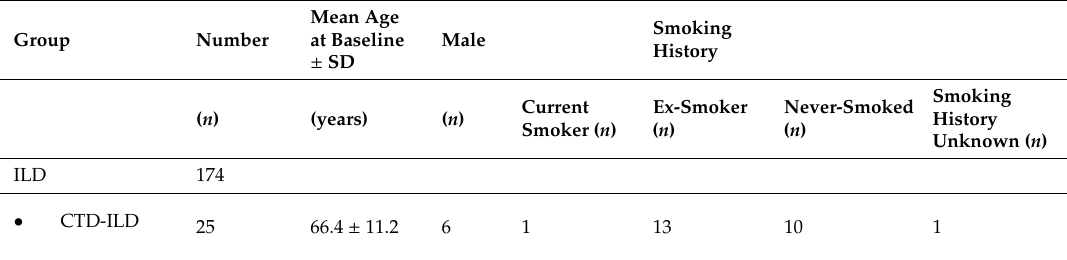
Table 1. Demographics of the eNose cohort, including ILD, COPD, and HC